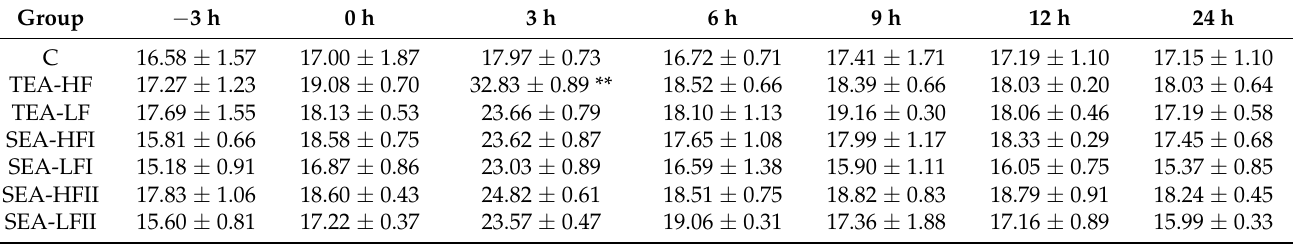
Table 1. Effects of different treatment methods on AST activity at different time points ( U/L, n = 6 ). Group − 3